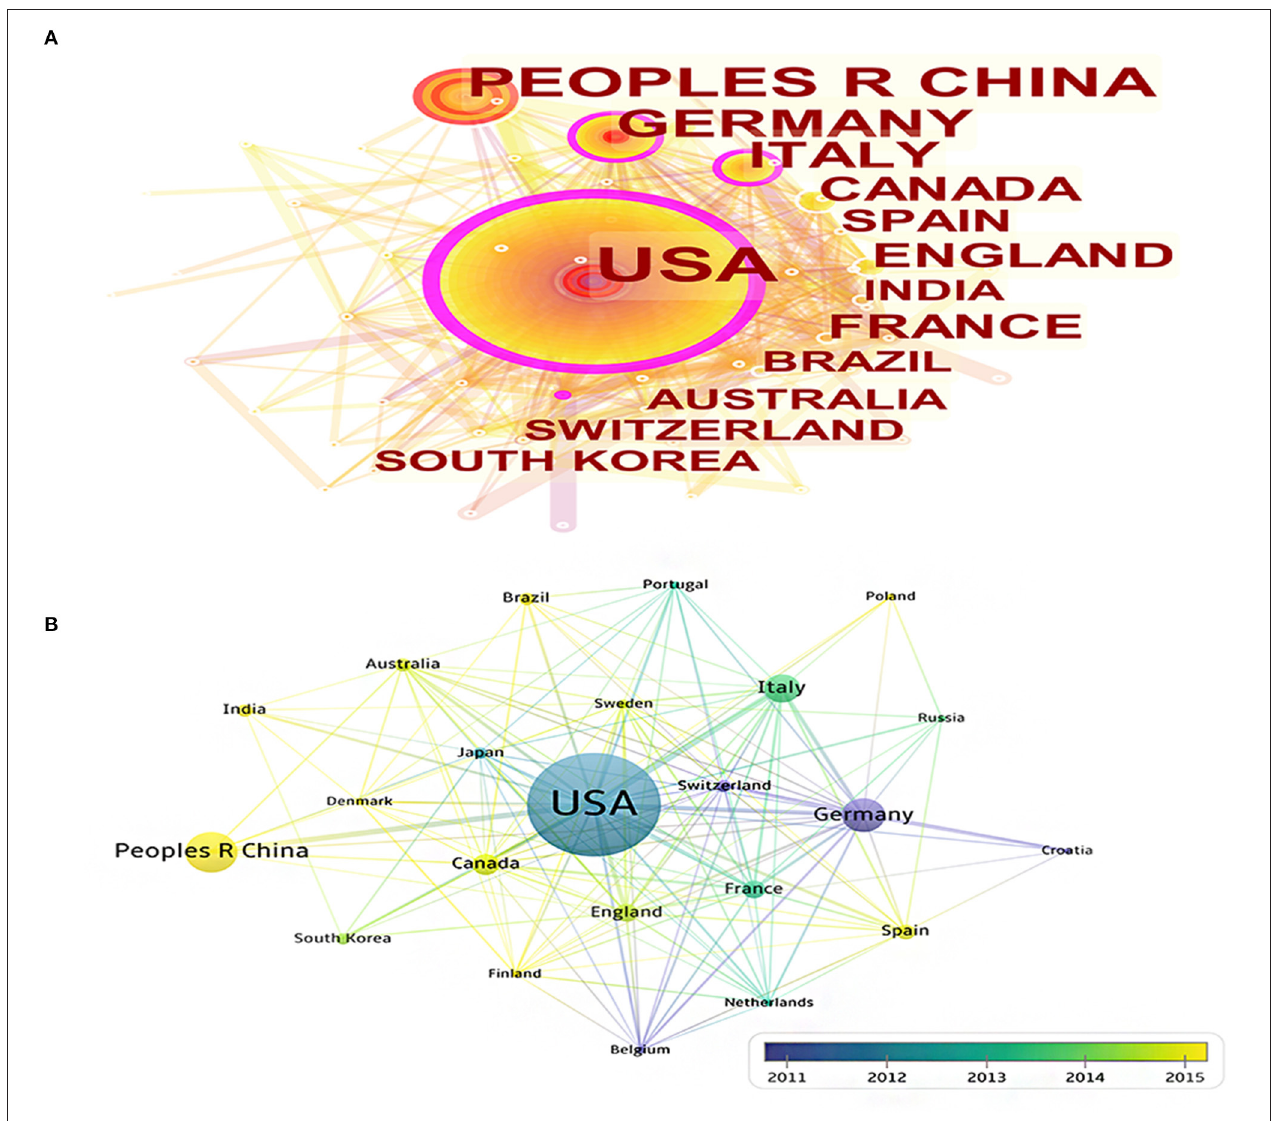
FIGURE 2 | (A) The cooperation network visualizations map of countries and regions based on CiteSpace; (B) The average annual publication year map of countries and regions based on VOSviewer.